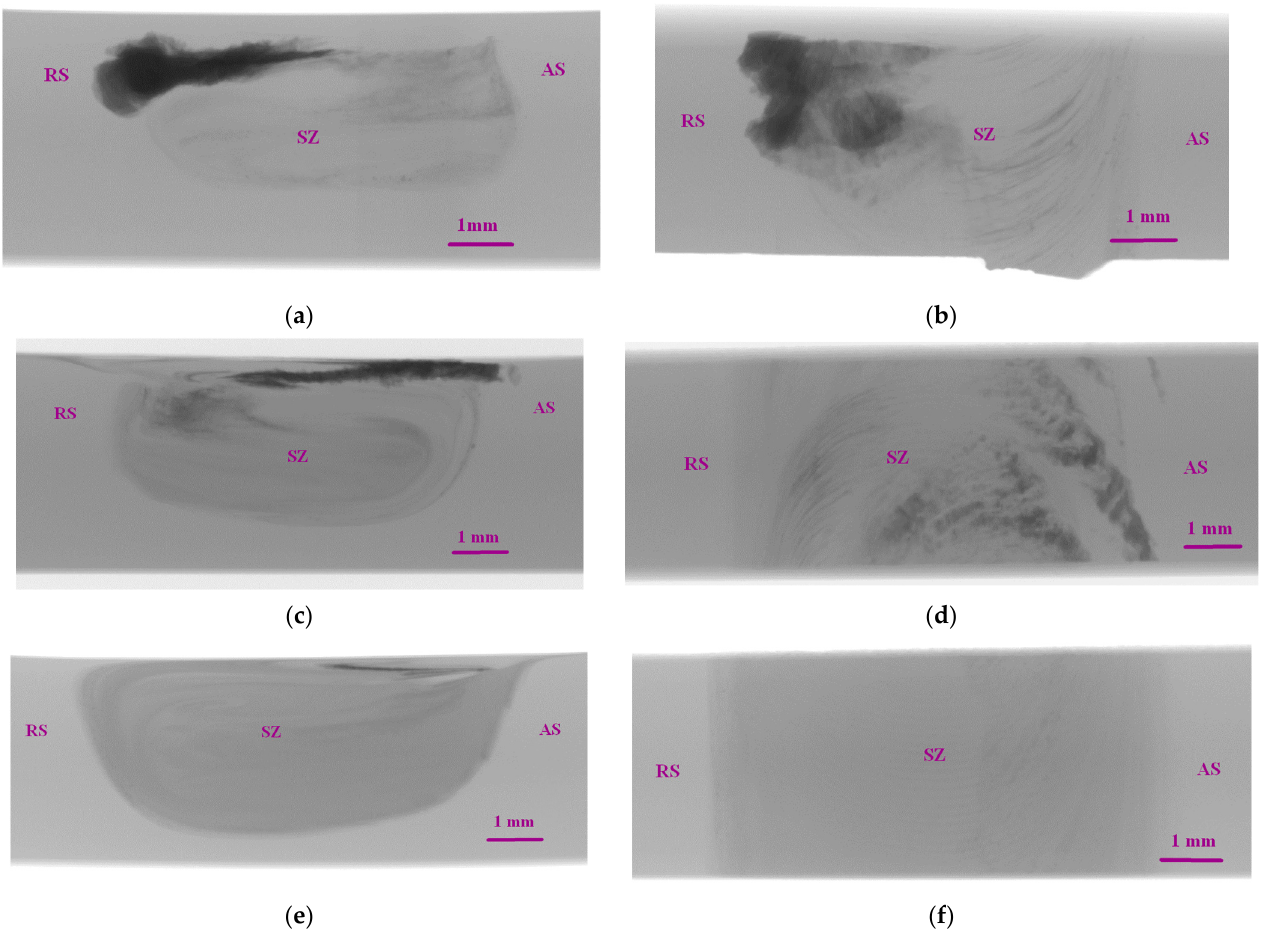
Figure 6. X-ray computer tomography images of the RPPs/AA5056 composite after: ( a , b ) 1st; ( c , d ) 4th; ( e , f ) 4th additional tool passes along the machining line. SZ—stir zone; RS—retreating side; AS—advancing side. ( a , c , e ) show the XCT layers as sectioned by the plane perpendicular to the FSP track axis. ( b , d , f ) show the XCT layer as seen from the direction perpendicular to the FSP track’s top surface.